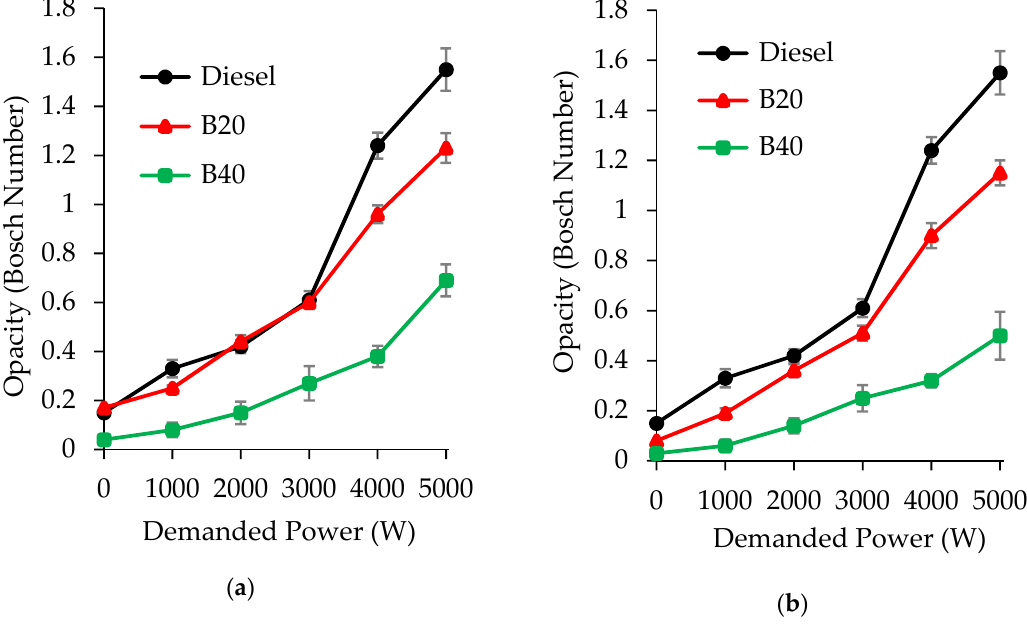
Figure 3. Smoke emissions (Bosch number) at different demanded power values (1–5 kW) for: ( a ) diesel / acetone / sunflower oil; ( b ) diesel / acetone / castor oil blends. The measure errors are represented as standard deviation using error bars.